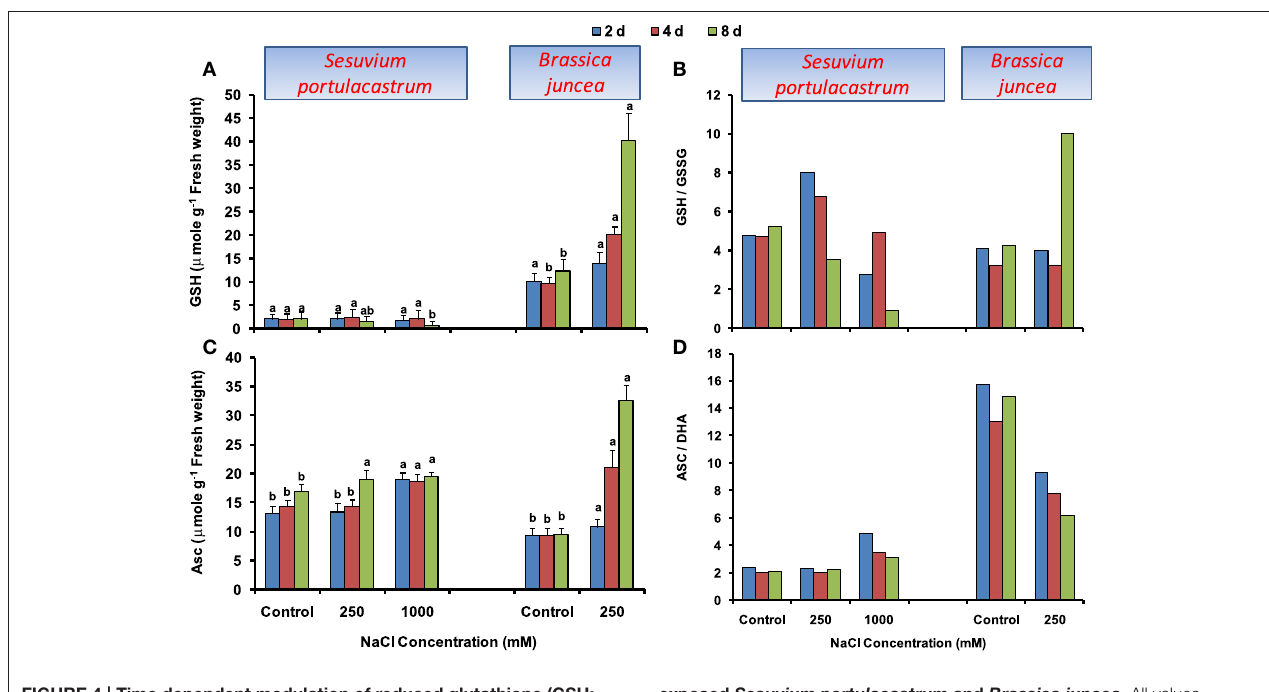
exposed Sesuvium portulacastrum and Brassica juncea . All values represent the mean of three replicates. Different letters indicate significantly different values at a particular duration (DMRT, P = 0